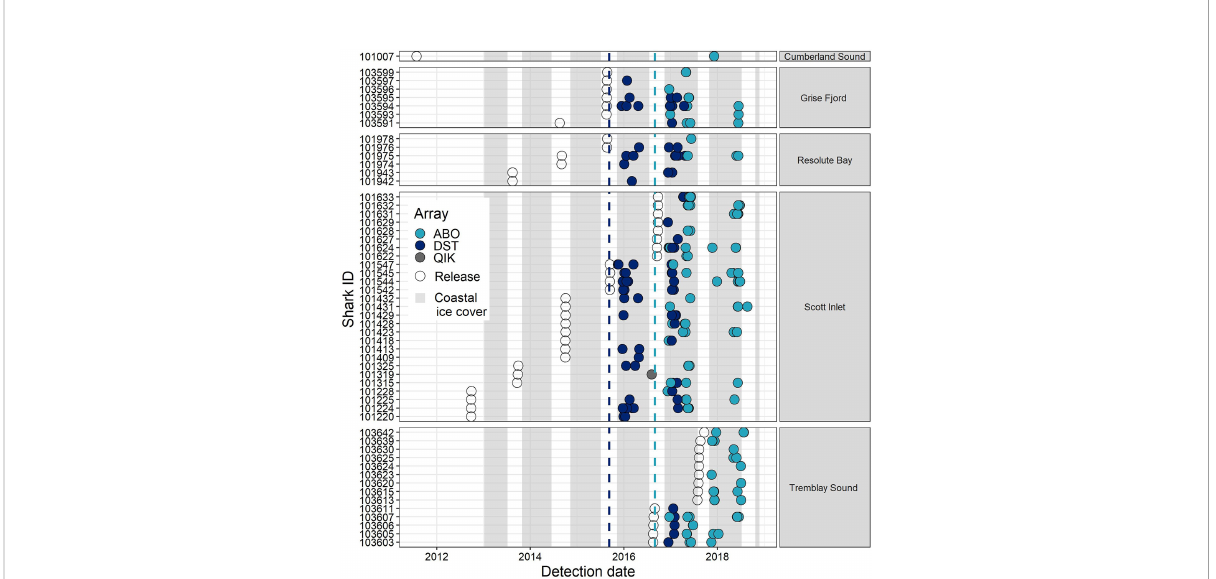
FIGURE 3 Temporal distribution of Greenland shark detections recorded by acoustic receiver stations in offshore Baf fi n Bay, listed by shark ID and coloured by array ID. Panels indicate the capture locations of individual sharks and open dots indicate the date of initial tagging and release for each individual. Vertical lines denote the date of fi rst deployment for DST and ABO arrays, respectively, as indicated by line colour. Shaded bars denote the annual periods of coastal ice cover between the timing of formation (>75% sustained cover) and breakup (<75% sustained cover) in Scott Inlet (Nunavut) throughout the study period (data available at: https://ice-glaces.ec.gc.ca/). [Colour online].